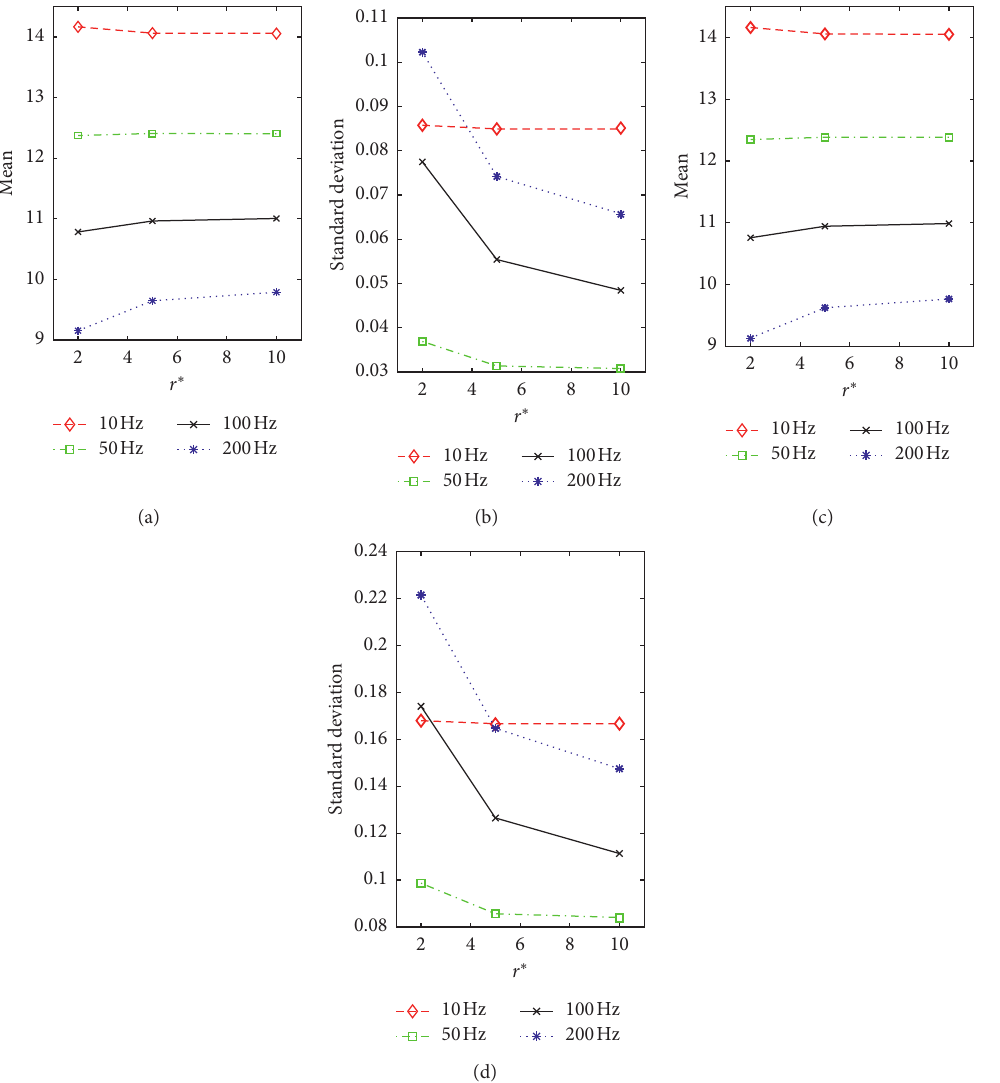
� 0.1); (b) standard deviation ( δ G